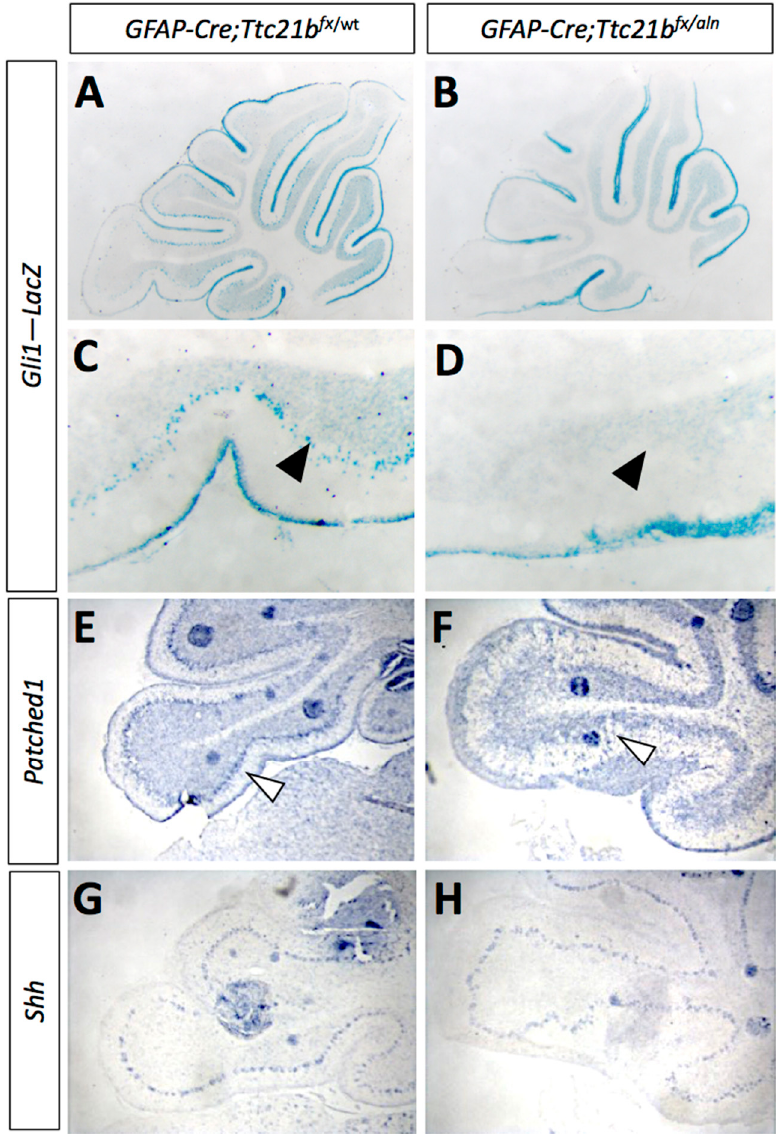
Figure 4. Shh signaling is reduced in GFAP-Cre;Ttc21b fx / aln cerebella. ( A – D ) P11 Gli1- LacZ activity is reduced in in the Purkinje cell layer (arrows) of the GFAP-Cre;Ttc21b fx / aln animals ( B , D ) as compared to control ( A , C ). ( E , F ) Patched1 expression is also reduced in the GFAP-Cre;Ttc21b fx / aln cerebella at P11 ( F ) compared to control ( E ), especially in the Purkinje cell layer (open arrowhead). ( G , H ) Shh expression appears similar between control ( G ) and GFAP-Cre;Ttc21b fx / aln ( H ), but the organization of Shh -expressing cells again appears disorganized in the lower lobe of the cerebellum in ablated animals.